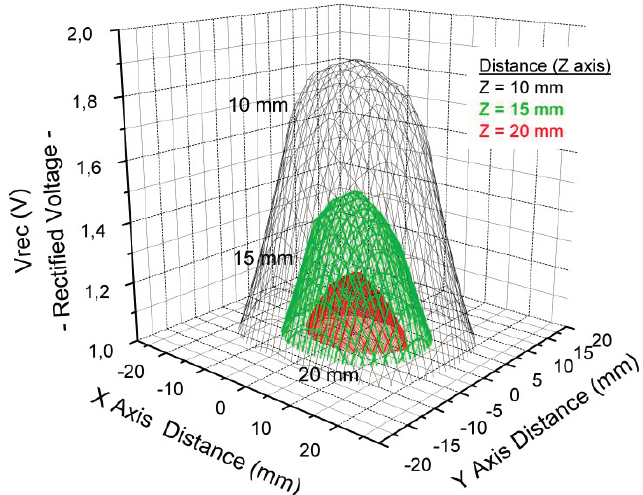
Figure 9. Distribution of the Vrec voltage in the XY plane for three different distances: 10, 15 and 20 mm (Reproduced from [60] with kind permission from Springer Science + Bussiness Media